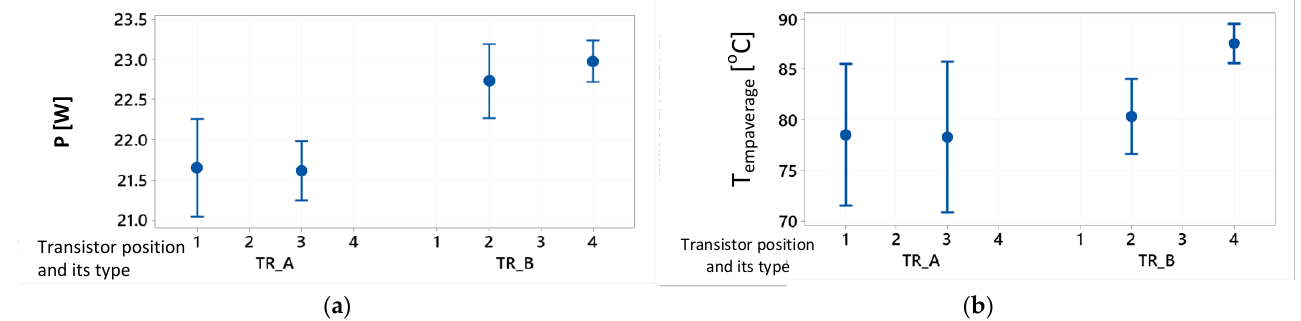
Figure 6. TR_A transistors in positions 1 and 3 and TR_B in positions 2 and 4, Interval Plot: ( a ) average value and distribution of power dissipated in the transistors, ( b ) average value and temperature distribution on the transistor cases at P = 21.5 W ± 10%.